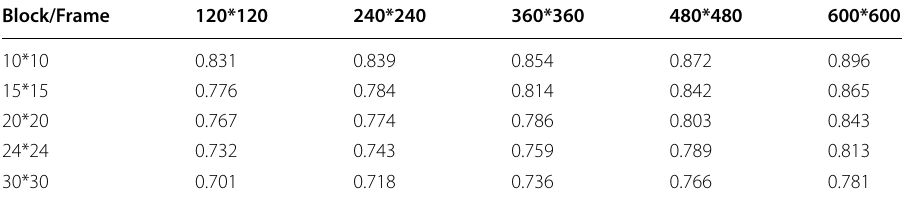
Table 2 F1‑Score performance of S ∗ using UCF11 dataset